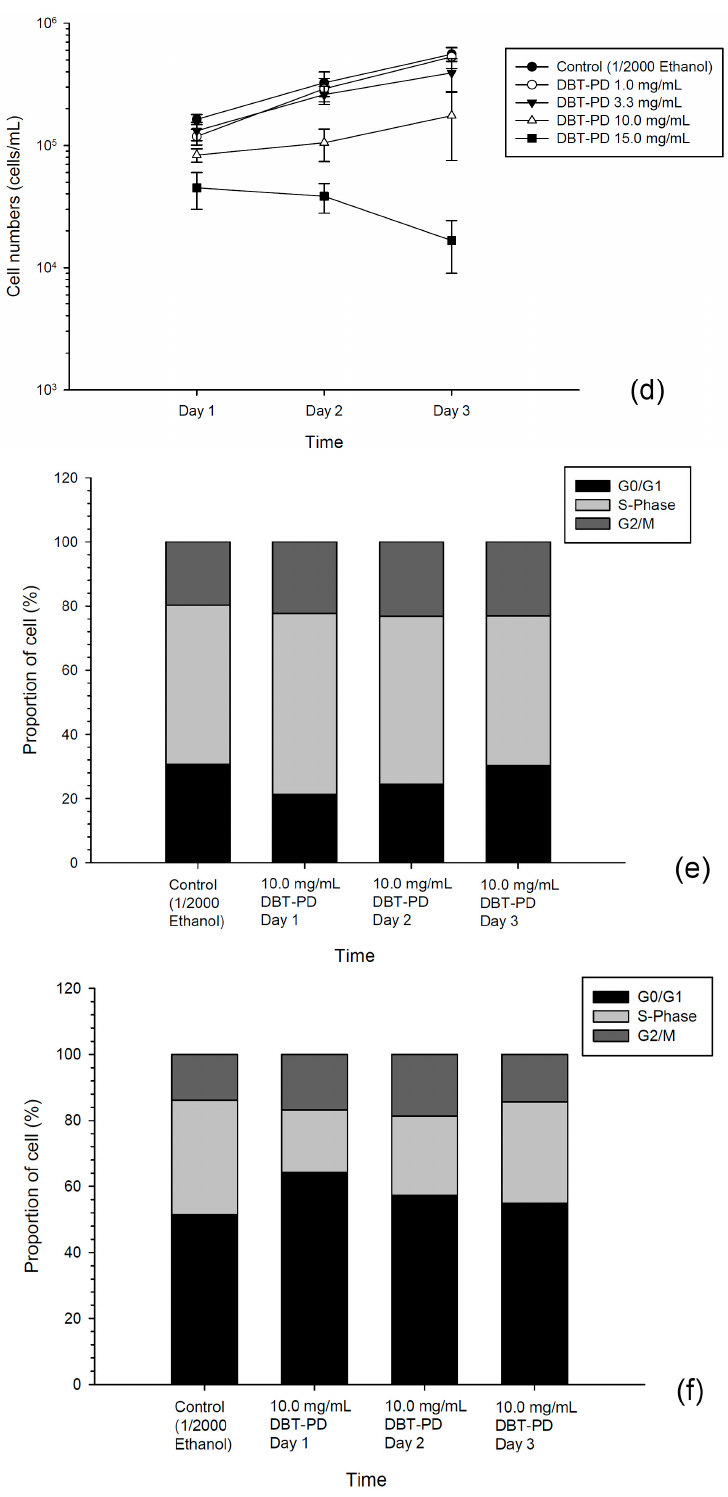
Figure 2. Viability and cell cycle analysis of CT26 and HT-29 cells after treatment with DBT. ( a , b ) Cells were cultured with 10.0 mg/mL DBT, DBT-PE, or DBT-PD for 24, 48 and 72 h. Cell viability was measured by Trypan blue dye exclusion; ( c , d ) Cells were cultured without or with DBT-PD (0–15.0 mg/mL) for 24, 48 and 72 h. Viable cells were counted by trypan blue exclusion assay. Data from at least three separate experiments are expressed as mean ± standard deviation; ( e , f ) Cell cycle analysis in CT26 cells treated with 10 mg/mL DBT-PD.